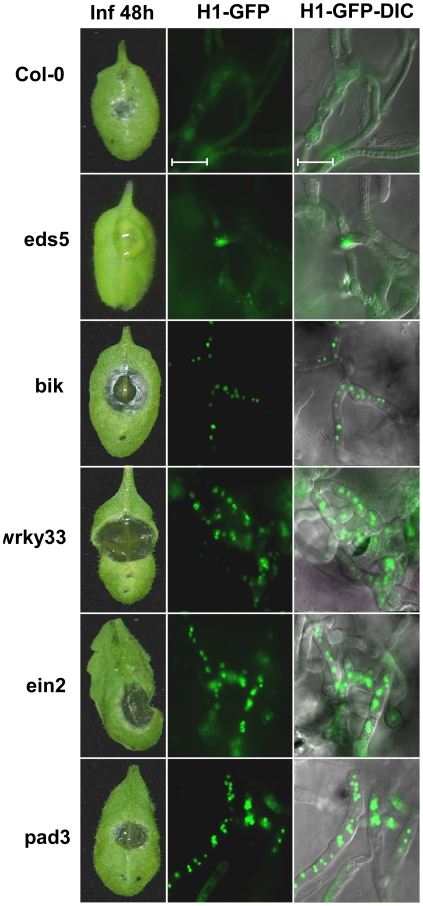
Lower PCD levels and enhanced pathogenicity of B. cinerea on A. thaliana immune-deficient plants.Leaves of all the plant lines were inoculated with spore suspension of the H1-GFP strain. Symptoms and GFP signals were recorded 48 h PI. Col-0 – wild type, eds5 – a mutant in SA signaling with slightly reduced sensitivity to B. cinerea (both the Col-0 and eds5 are used a controls), bik1, wrky33, ein2, pad3 are mutant lines with defects in the immune response (see text for details) and are hyper sensitive to B. cinerea. Enhanced pathogenicity on these mutants is paralleled by retention of intact nuclei (H1-GFP images).